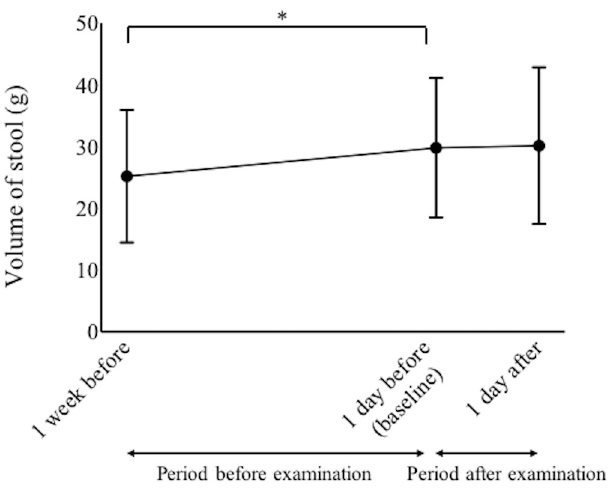
Fig 4. The daily stool volumes measured from 1 week before examination to 1 day after examination. � Statistical difference (p < 0.05, paired-t tests with Bonferroni